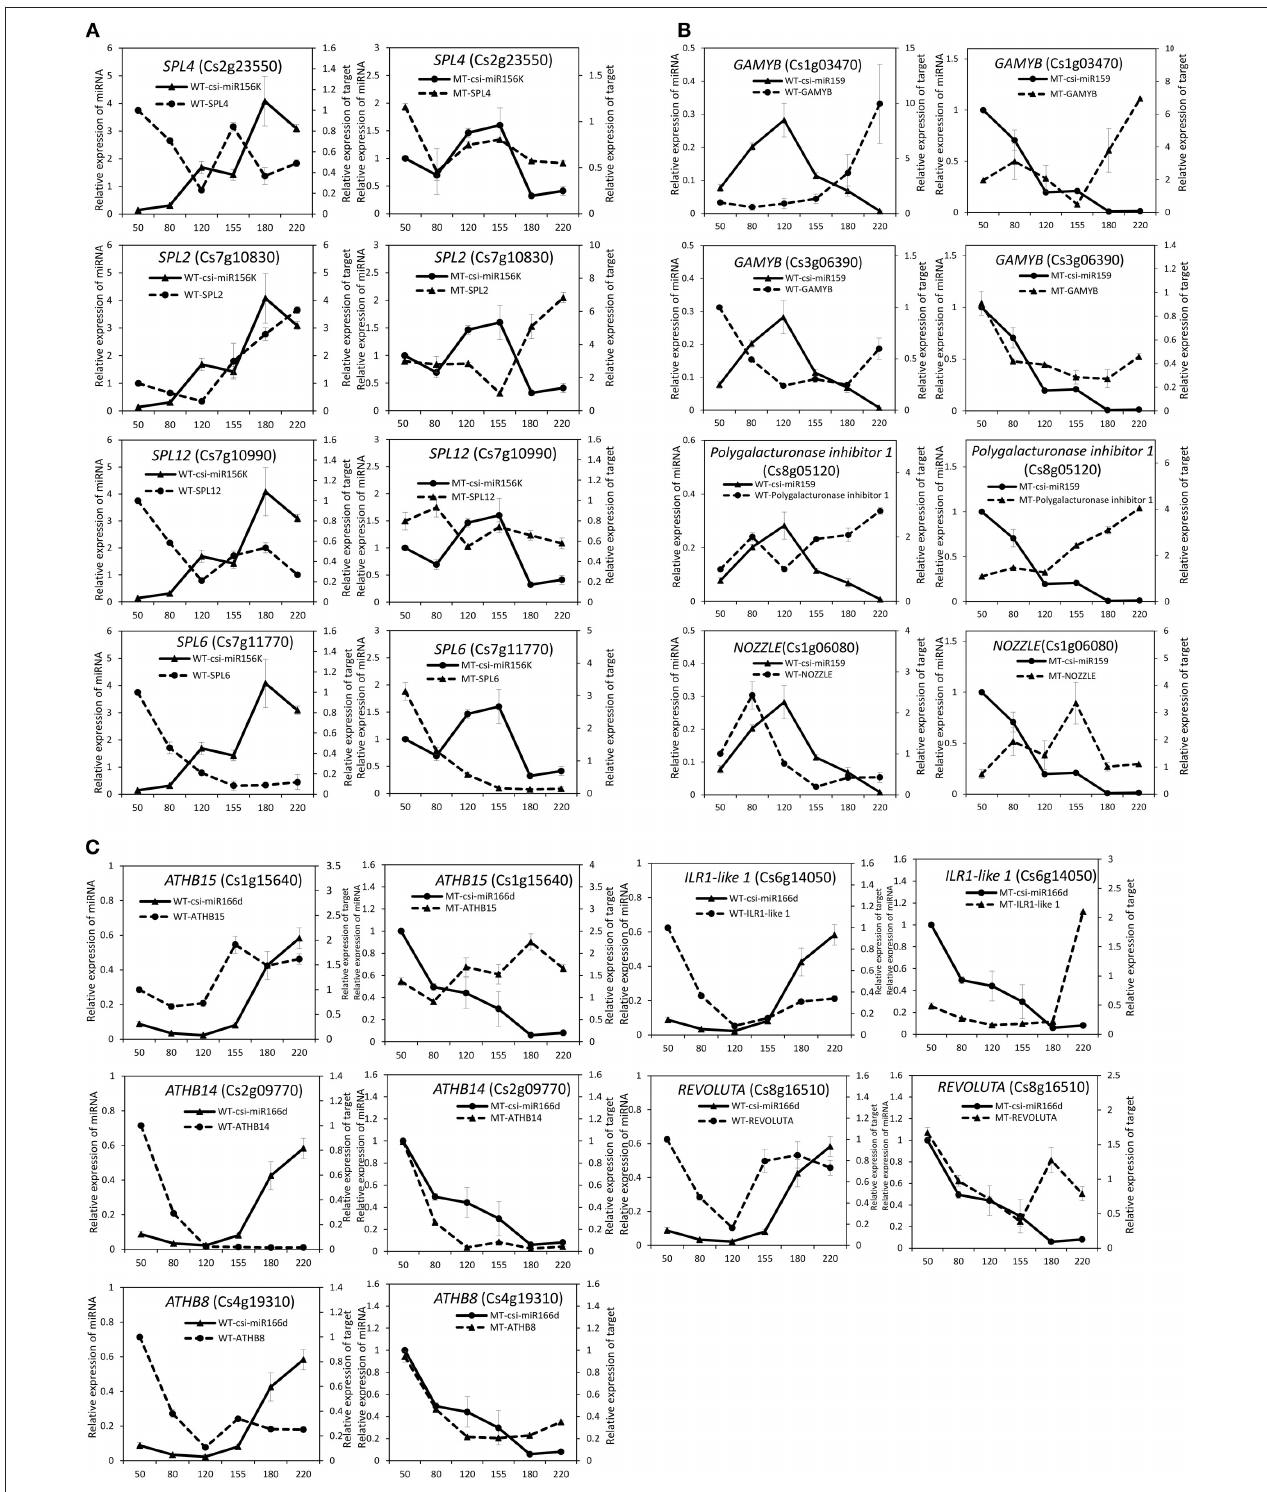
FIGURE 5 | Expression patterns of known miRNAs and their target genes in MT and WT during fruit development and ripening. (A) , csi-miR156k; (B) , csi-miR159; (C) , csi-166d.